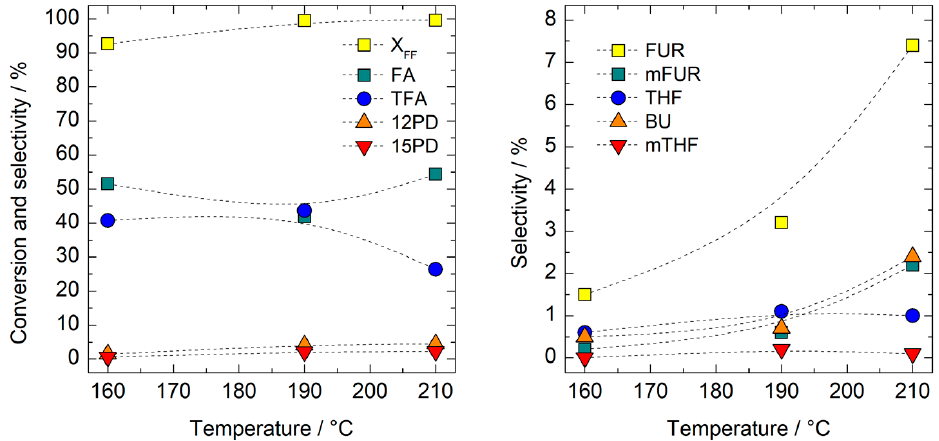
Figure 10. Furfural conversion and product selectivity over Ni 2 Mg 1 Al-R: effect of reaction tempera- ture at 50 bar of H 2 and 2 h using 5 wt.% FF in ethanol (the dashed lines only indicate trends).